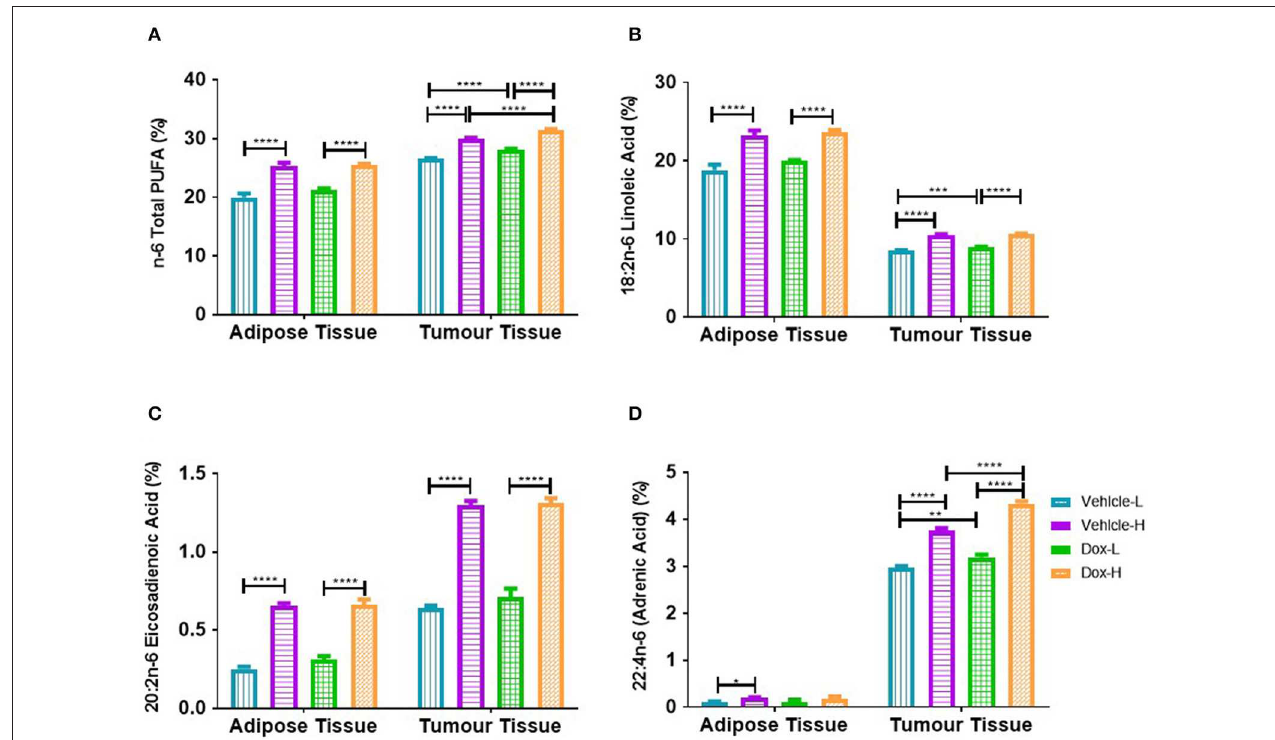
FIGURE 11 | Polyunsaturated fatty acid composition; (A) Total n-6 PUFAs, (B) Linoleic Acid, (C) Eicosadienoic Acid, and (D) Adrenic Acid of mammary adipose-and-tumor tissue of mice fed a LFD or HFD with either vehicle control or doxorubicin treatment. Results are presented as mean ± SEM ( n = 5). Two-way ANOVA with Fisher’s LSD post hoc correction was applied and p < 0.05 was considered as statistically significant. * p < 0.05, ** p < 0.01, *** p < 0.001 and **** p <